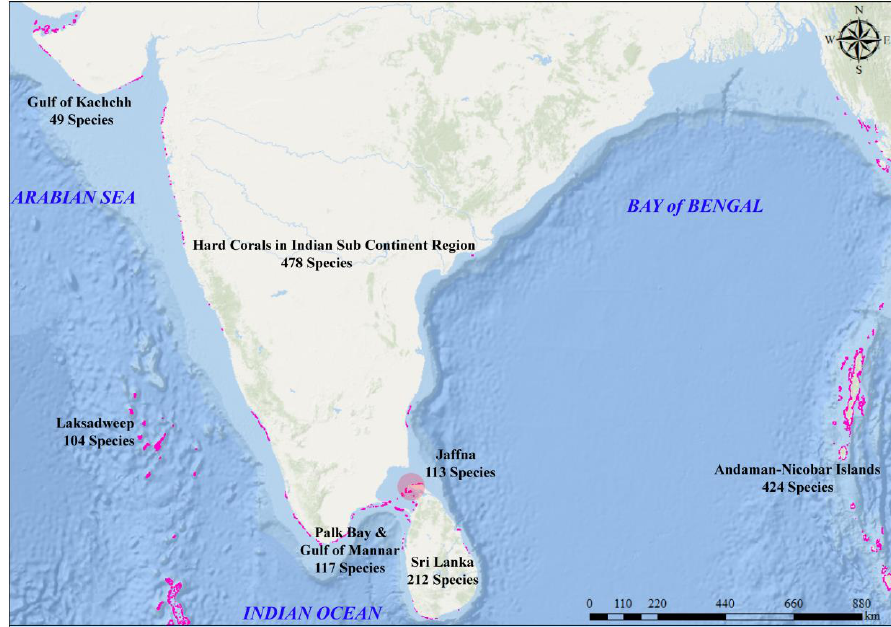
Figure 7. Comparison of the numbers of scleractinian corals recorded in different parts of India and Sri Lanka in relation to the Jaffna Peninsula and its islands. Pink colouring indicates the location of reef areas; the pink circle in the centre indicates the location of the present study areas at the northern end of Sri Lanka)